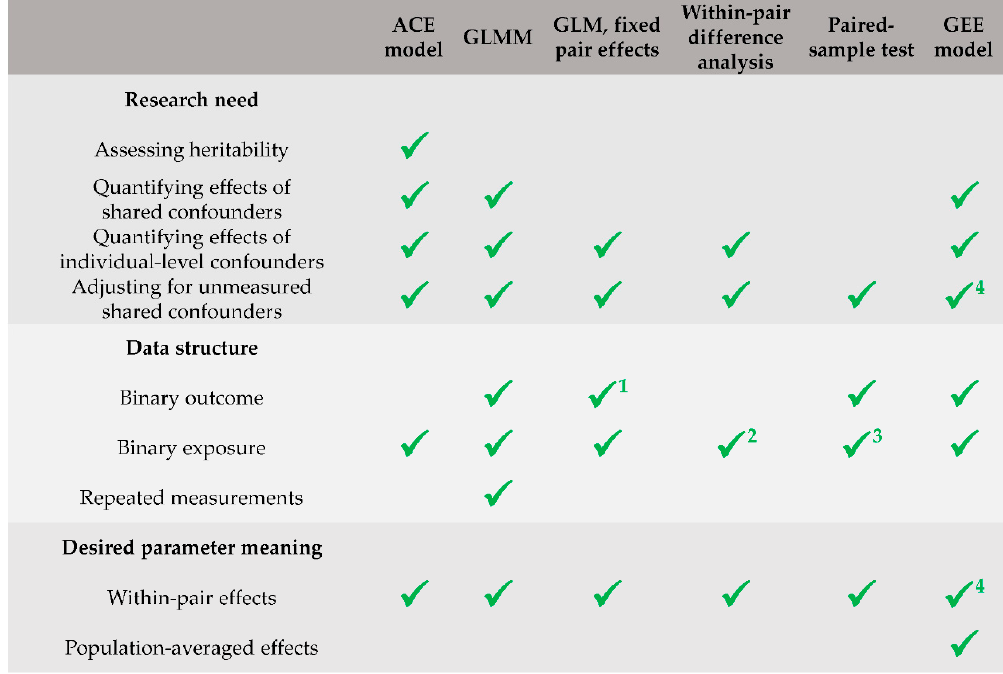
Figure 2. Summary of recommendations regarding which types of models researchers should favor under different conditions (research needs, data structure, and desired parameter meaning). 1 Conditional logistic regression is recommended. 2 Accommodated for through the use of dummy variables. 3 Either the outcome or the exposure mustable t be binary. 4 Only in models with identity link function and in log-linear models.